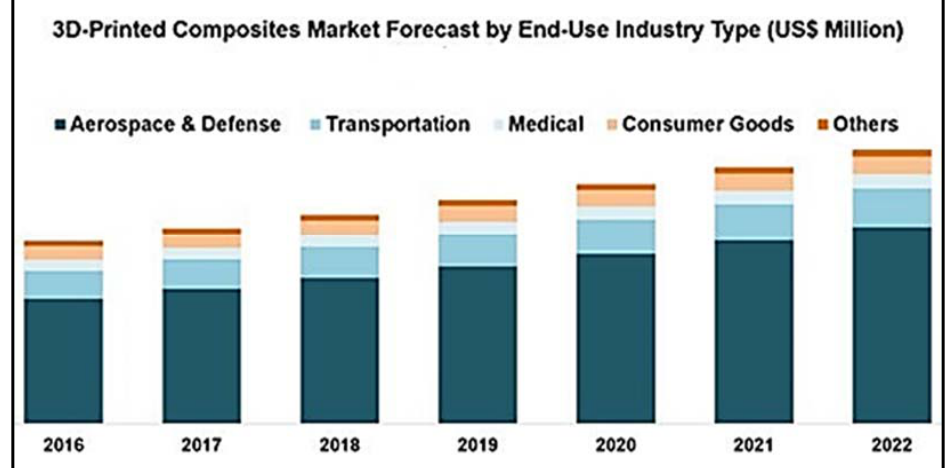
Figure 3. Forecast of the market growth of 3D-printed composites [17].